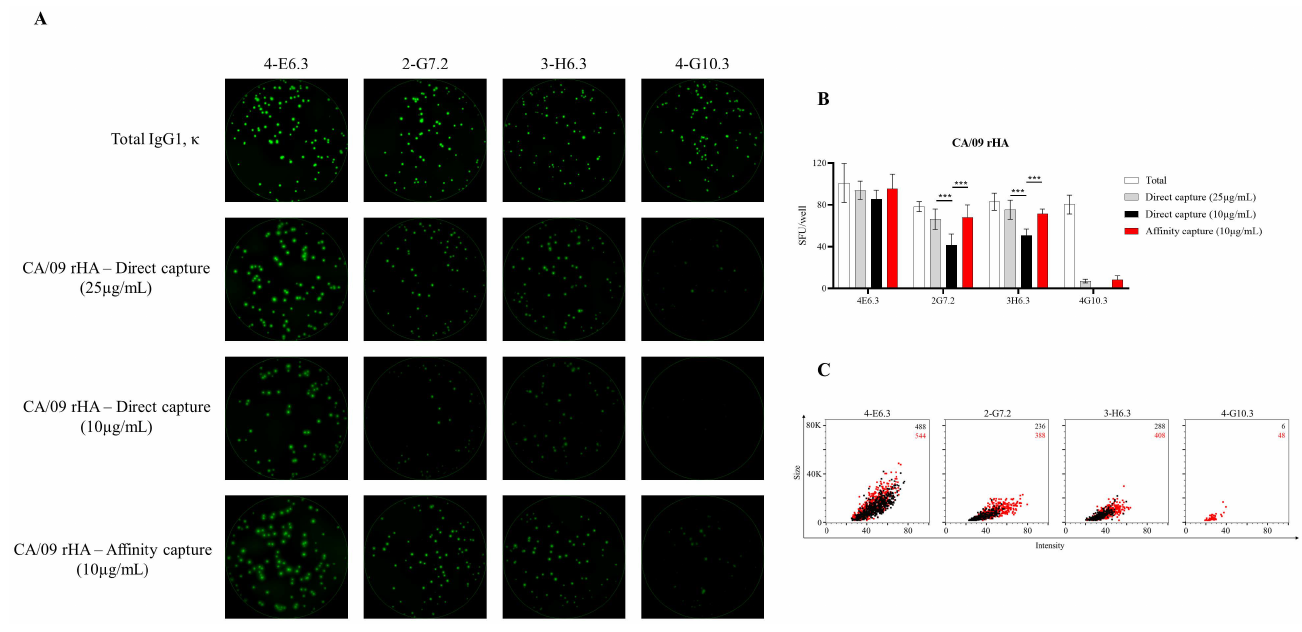
Figure 7. Detection of CA/09 rHA-specific FluoroSpots is influenced by protein-coating efficiency. Murine B-cell hybridomas (~100 cells/well) were evaluated for total or antigen-specific FluoroSpot formation. ( A ) Representative well images of murine B-cell hybridomas secreting monoclonal antibody (mAb) (IgG1, κ ) with specificity for the recombinant hemagglutinin protein representing the A/California/04/2009 (CA/09) H1N1 vaccine strain. Contrast enhancements were uniformly performed on all images to aid their visualization in publication. ( B ) Total or CA/09 rHA-specific SFU/well (mean ± SD) for each B-cell hybridoma line. Significant differences in SFU/well were determined using an analysis of variation (ANOVA) with Sidak’s post hoc test. *** p < 0.001. ( C ) CA/09 rHA-specific FluoroSpots were merged into FCS files and visualized as bivariate plots. FluoroSpots originating from assay wells in which CA/09 rHA was directly captured on the membrane (black dots) or through affinity capture (red) are shown as overlays. The combined number of FluoroSpots detected in replicate wells for each of the respective donors is indicated in the inset using the same red/black color